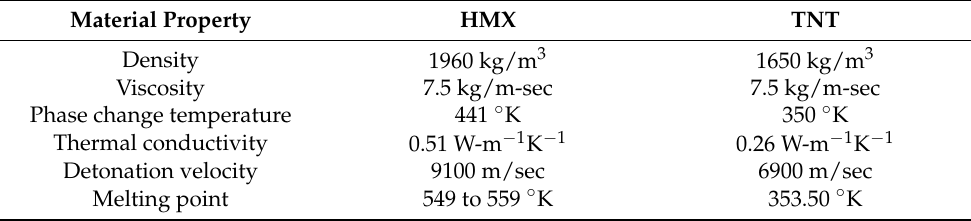
Table 1. Physical and mechanical properties of the mixing